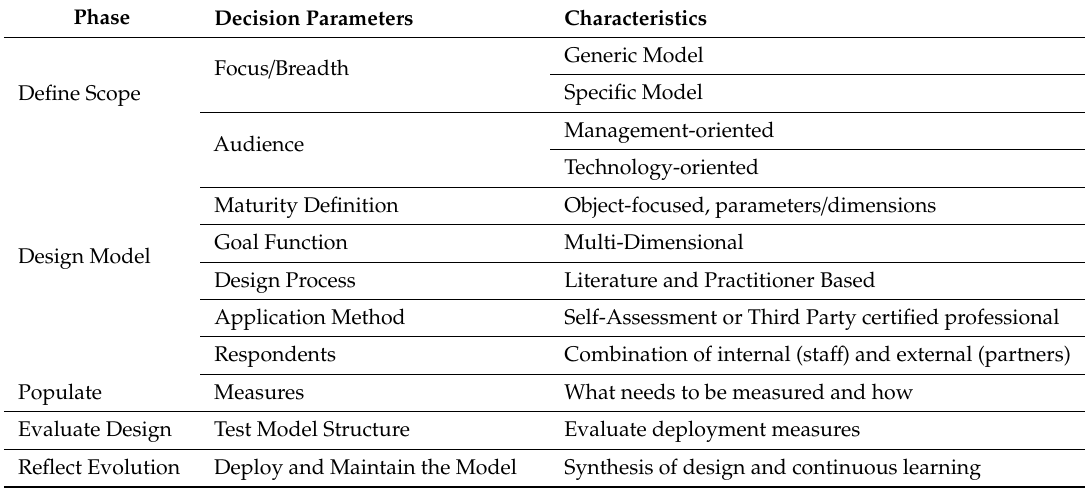
Table 2. Procedure for selection or development of Maturity Models, adapted from De Bruin et al. [53], Menon et al. [16] and Mettler